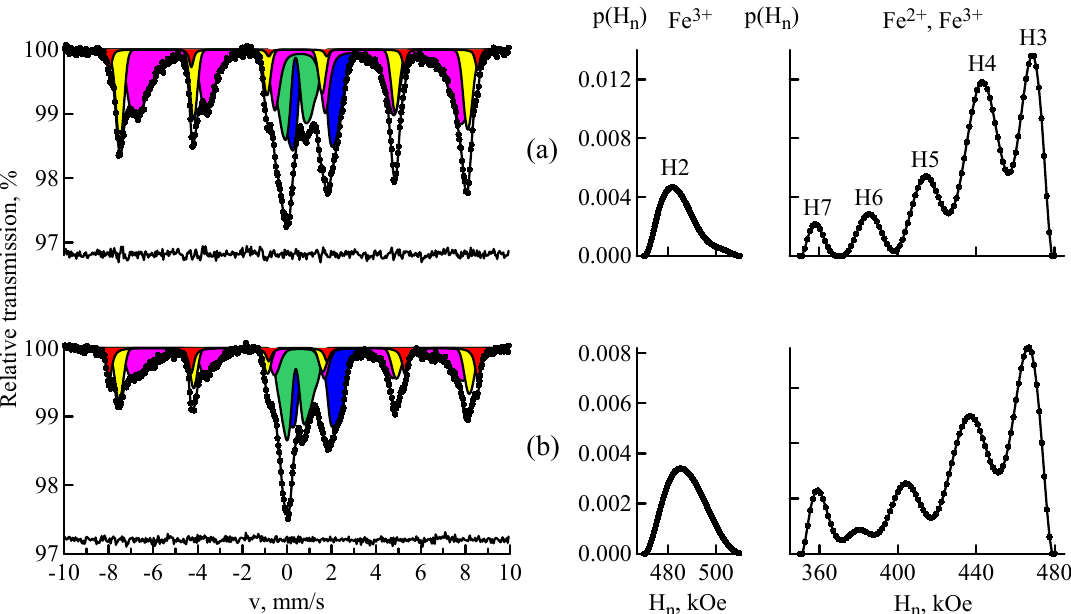
Figure 2. MS spectra of 57 Fe nuclei in the samples of fly ashes FA1 ( a ) and FA2 ( b ); and restored distributions of hyperfine magnetic field p(H n ): hematite (red), magnetite (yellow and magenta), the paramagnetic minerals (blue and green). Table 1. Hyperfine parameters of the magnetic fraction obtained from the MS spectrum of the fly ash